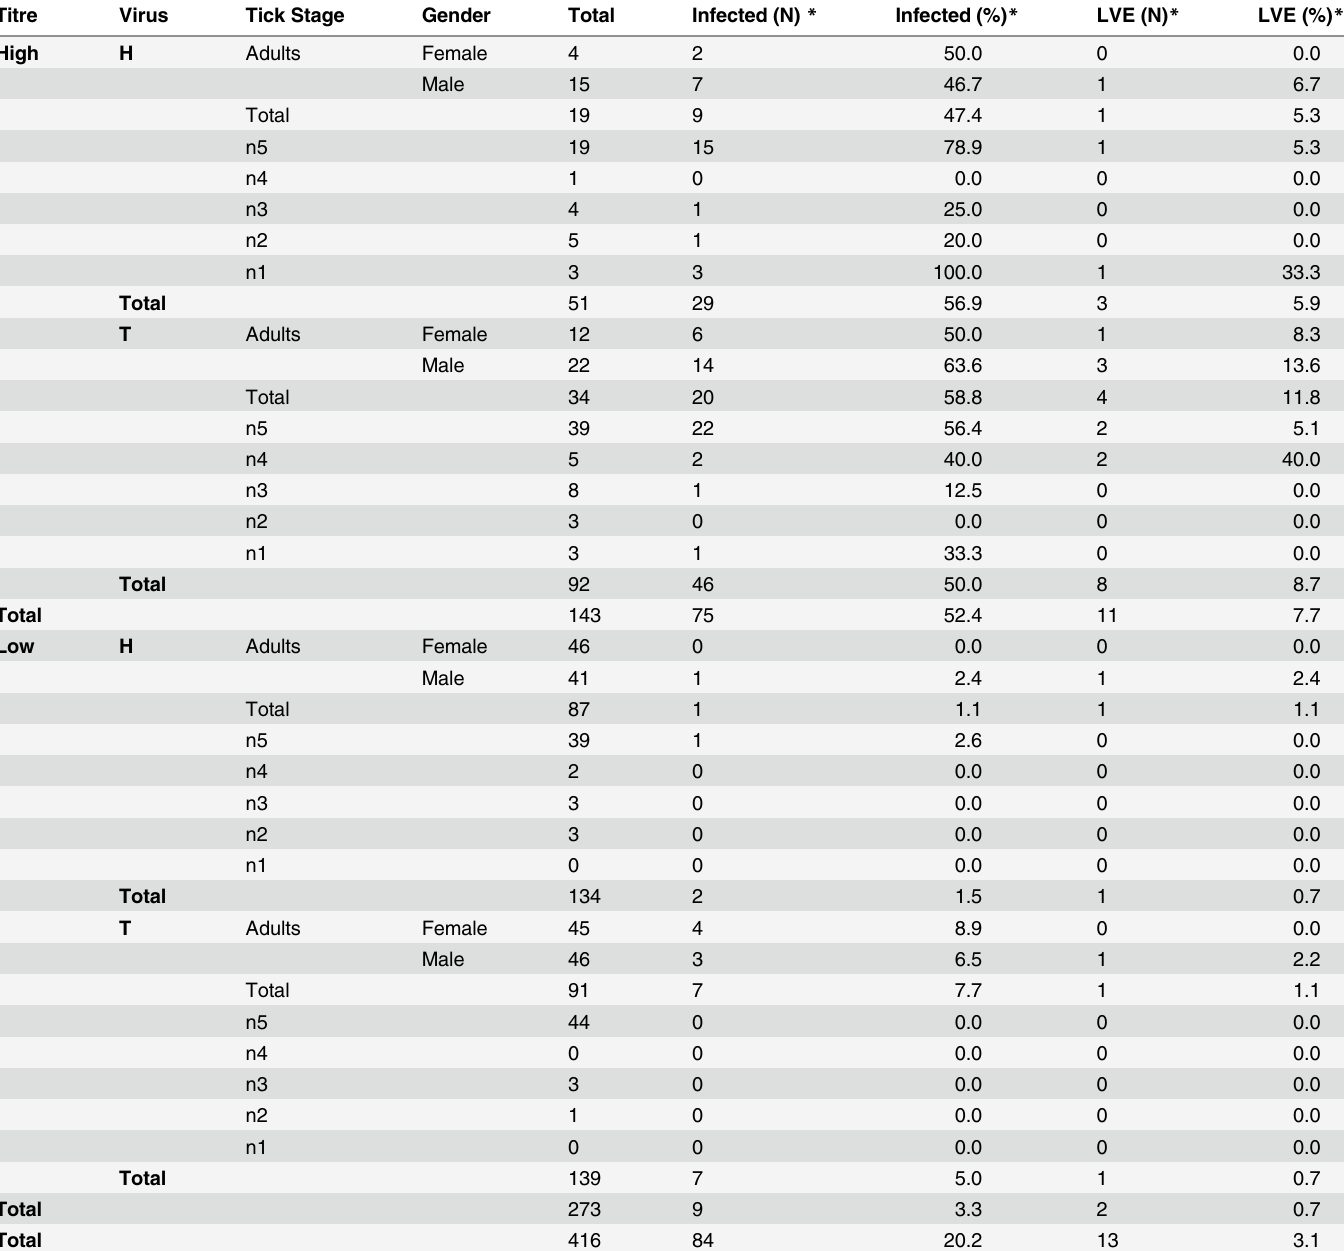
Table 4. Proportion of ticks fed on membranes infected with high and low virus titres of strains H and T that became infected and with likelihood of virus excretion (LVE). Titre